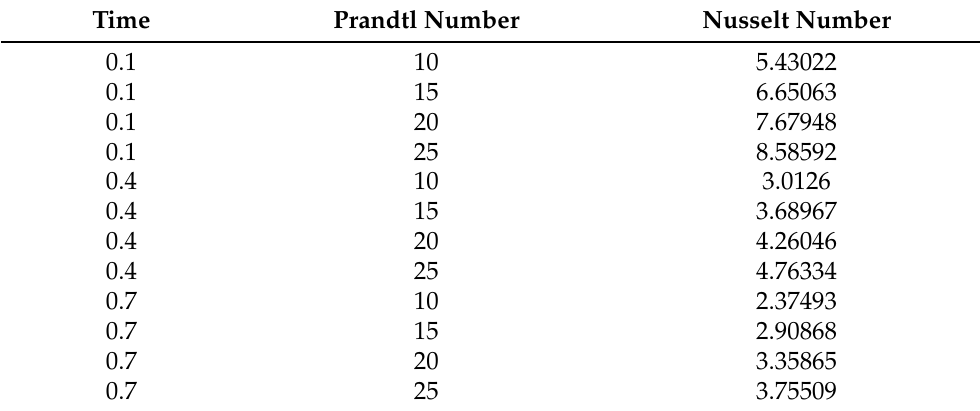
Table 2. Pr number values versus Nu number values for the various values of